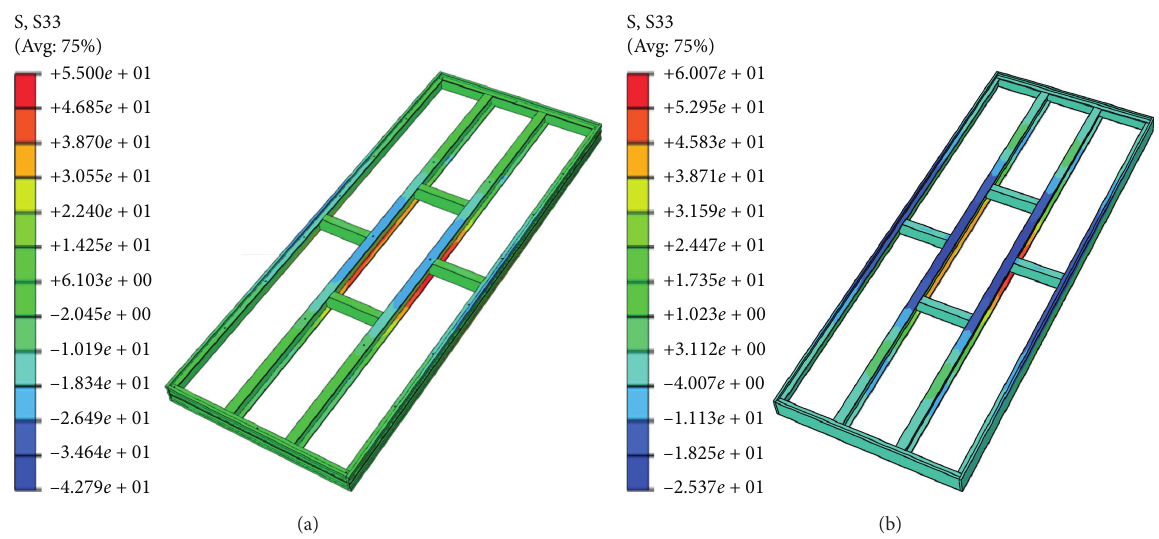
Figure 22: Longitudinal stresses of the frame (unit: N/mm 2 ). (a) Refined model. (b) General model.